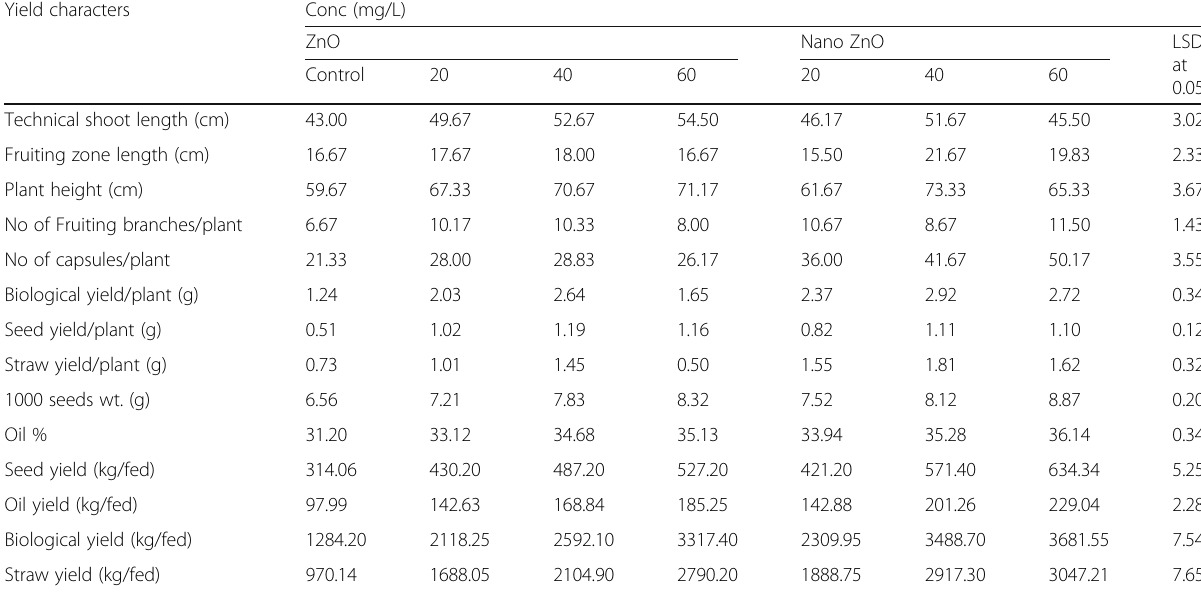
Table 6 Effect of ZnO or nano ZnO different concentrations (0, 20, 40, and 60 mg/l) on yield and yield components of flax plant under sandy soil (data are means of two seasons) Yield